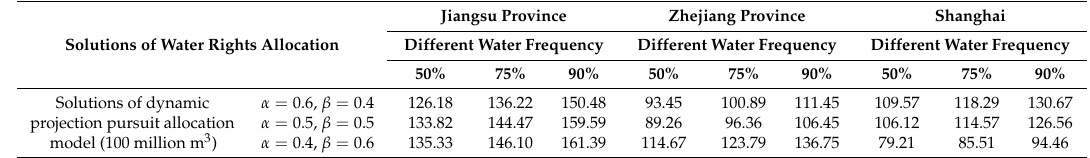
Table 5. Multiple scenarios of solutions for provincial initial water rights allocation in Taihu